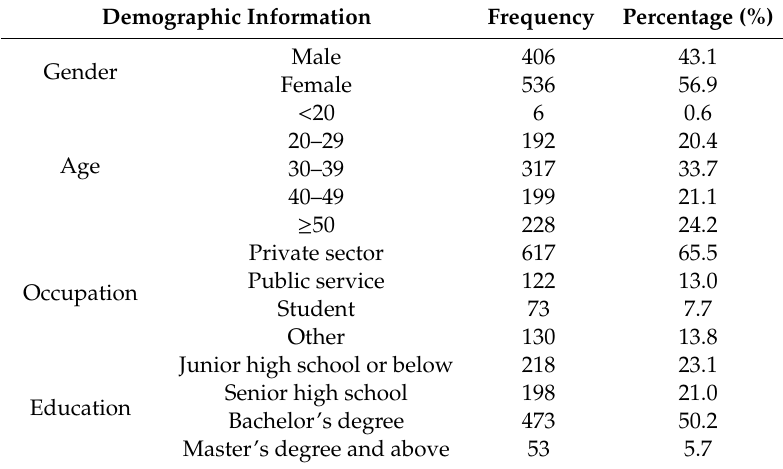
Table 1. Demographic